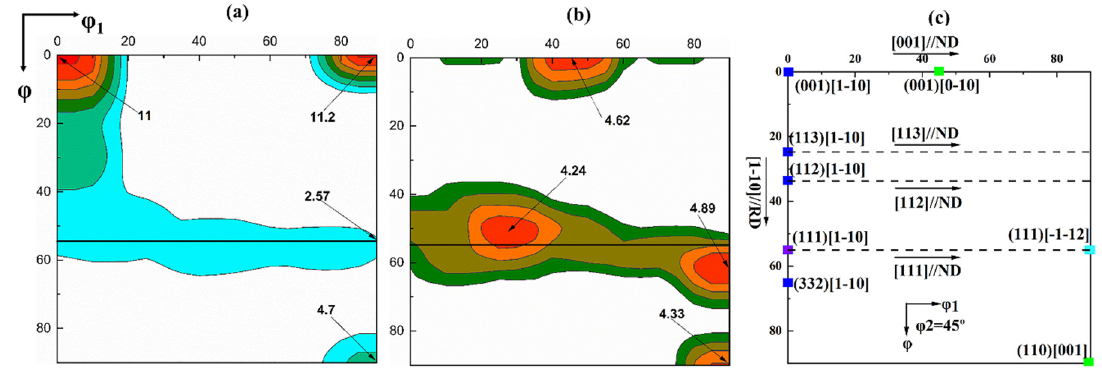
Figure 7. The φ 2 = 45° section of the ODF obtained from EBSD after annealing (ASR). ( a ) Annealing at 650 °C; ( b ) annealing at 750 °C; ( c ) typical texture components and orientation rotation path displayed in the φ 2 = 45° section of the ODF.